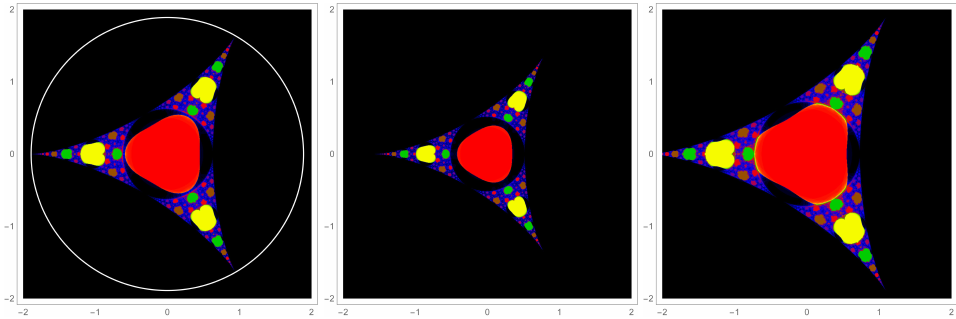
Figure 1. The j -averaged Mandelbrot set for simple inversion (left panel: I = ( 0,1,1,0 ) ) and scaled inversion (middle panel: A = ( 0,0.75,1,0 ) and right panel: A = ( 0,1.25,1,0 ) ). A circle of radius r = 1.889090 circumscribes the simple inversion Mandelbrot set. Scaling with a number less than 1 leads to a smoothing of the Mandelbrot set relative to the unscaled set. Conversely, scaling by a factor greater than 1 leads to greater roughness of the